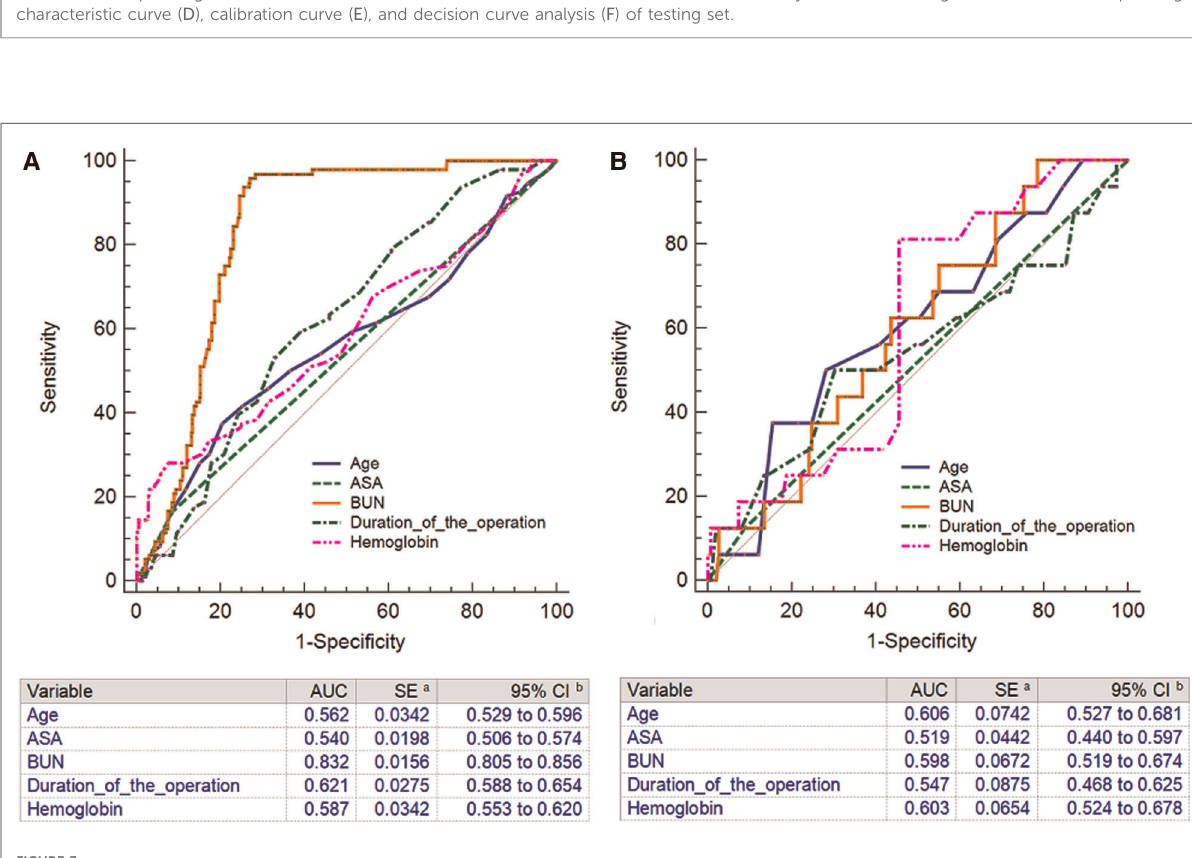
FIGURE 3 The receiver operating characteristic curves with corresponding area under the curves of nomogram and independent predictors in training set ( A ) and testing set ( B ). BUN: Blood urea nitrogen; ASA: American Society of